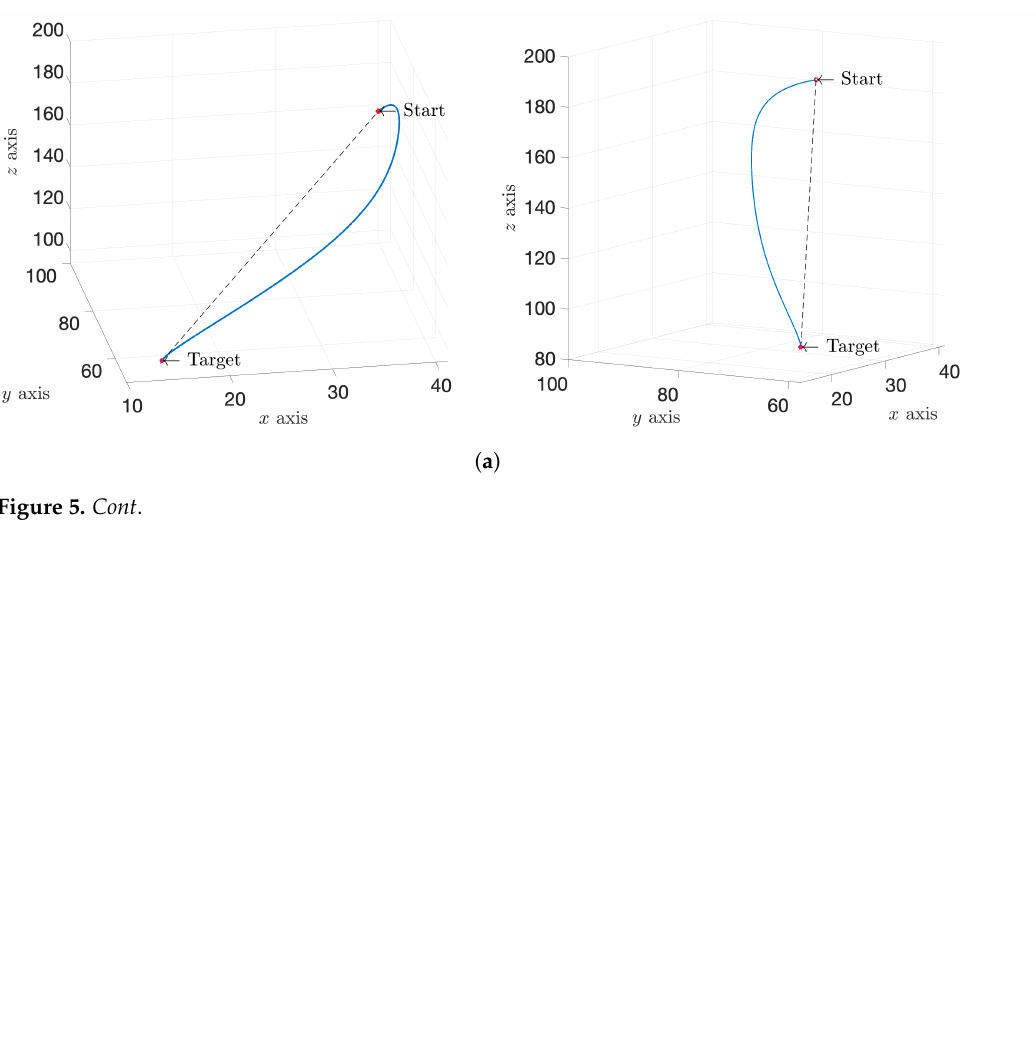
Figure 4. Experiment: Target point below the start point, favorable initial conditions. ( a ) Target approaching trajectory; ( b ) Control figures.